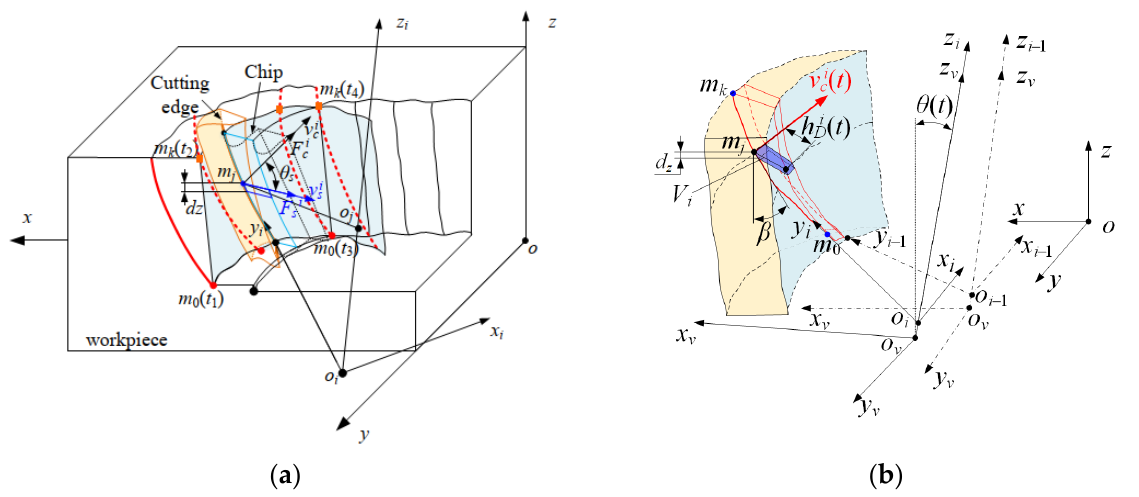
Figure 3. Instantaneous cutting boundary of cutting edge and instantaneous cutting volume. ( a ) Instantaneous cutting boundary of cutting edge; ( b ) instantaneous cutting volume.